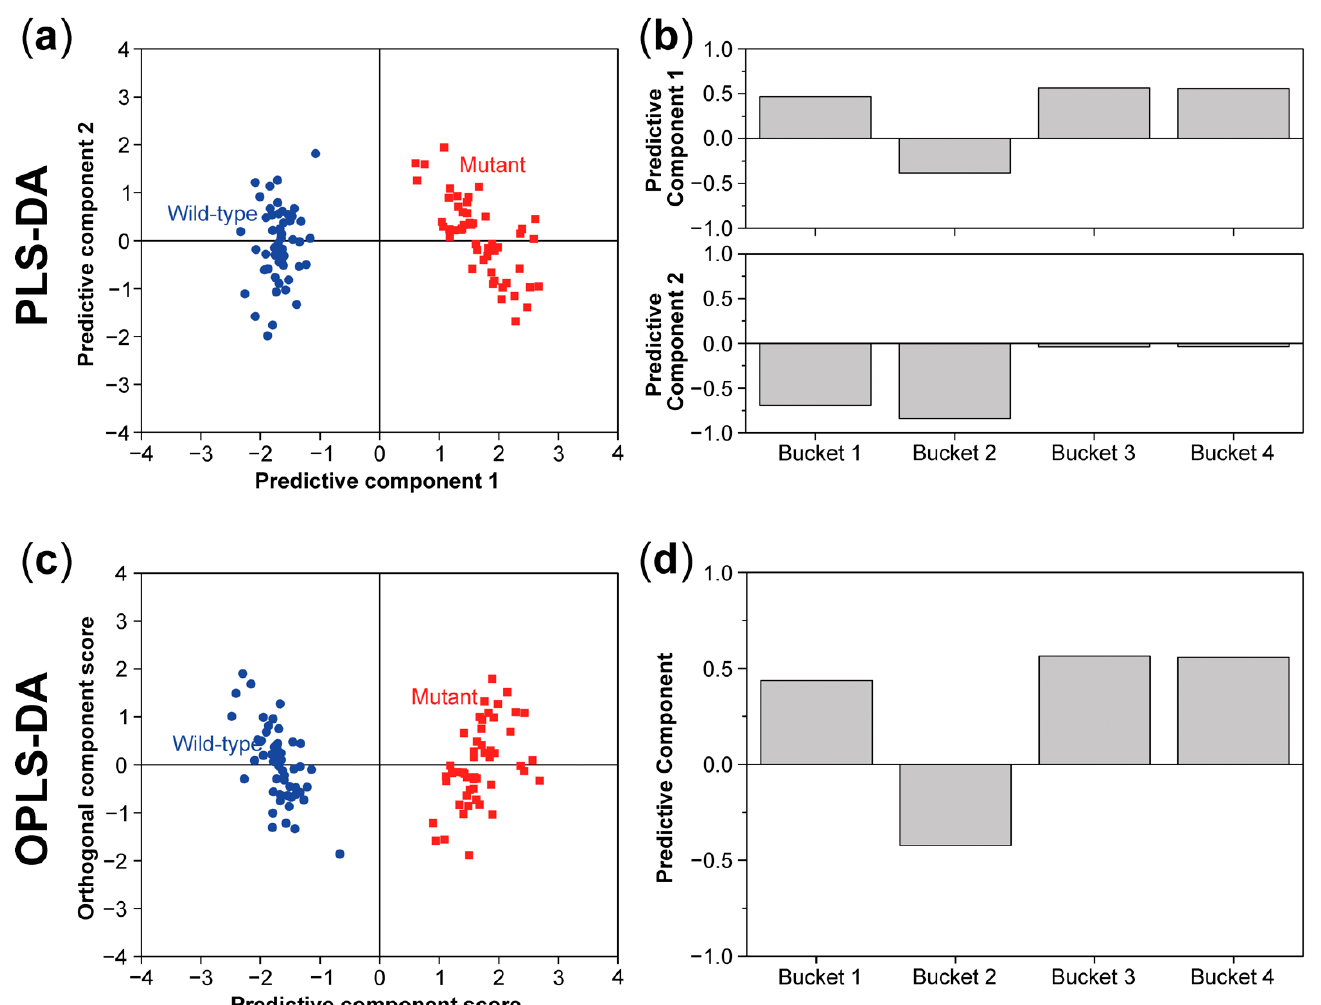
Figure 8. Partial least squares discriminant analysis (PLS-DA) score ( a ) and loading plot ( b ) and orthogonal partial least squares discriminant analysis (OPLS-DA) score ( c ) and loading plot ( d ) for the same data set as described in Figure 6. In both models, there is also a clear separation between the wild type and mutant in the score plots.